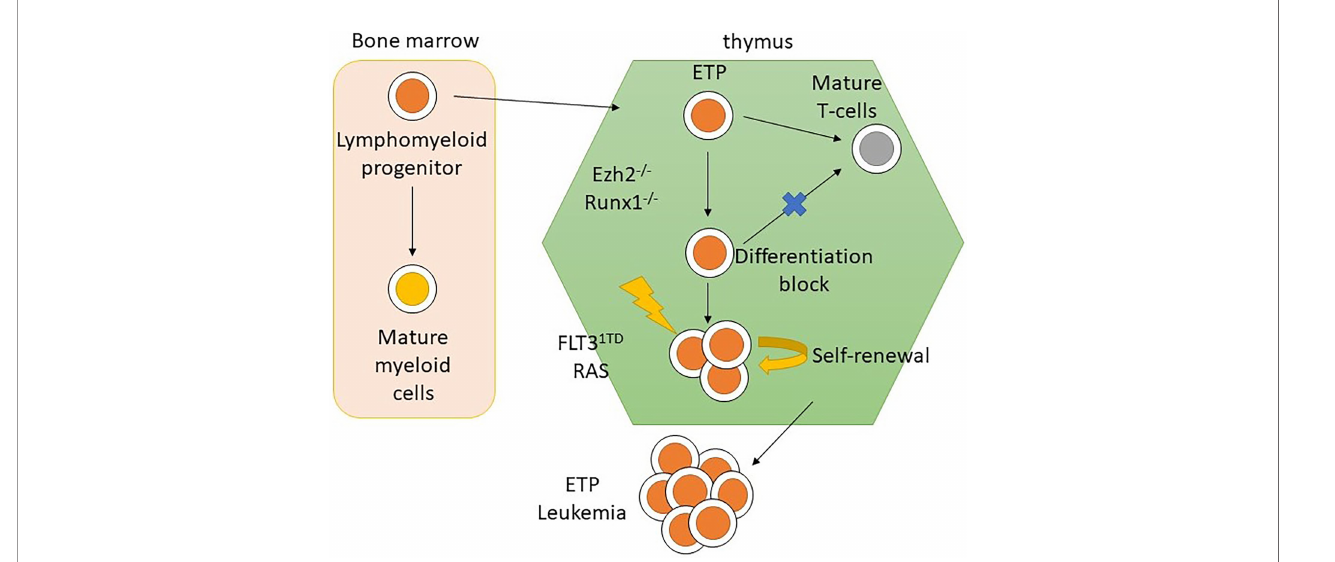
FIGURE 5 | The role of mutation in EZH2 , RUNX1 , RAS , and FLT3 -ITD in leukemogenesis of